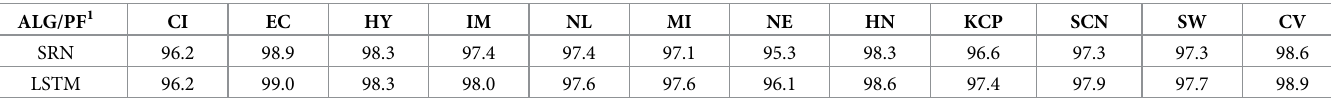
Table 2. ACC lab of all pathological findings for Att-RethinkNet based on LSTM and SRN for liver data set. ALG/PF 1